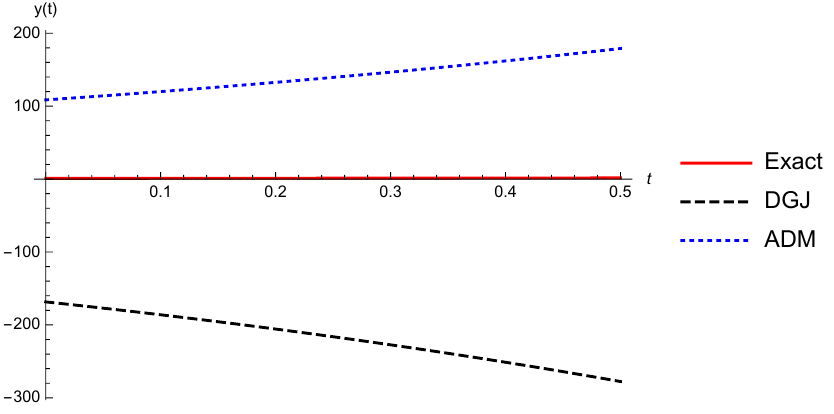
Figure 4. Comparison of DGJ, ADM and exact solutions of System